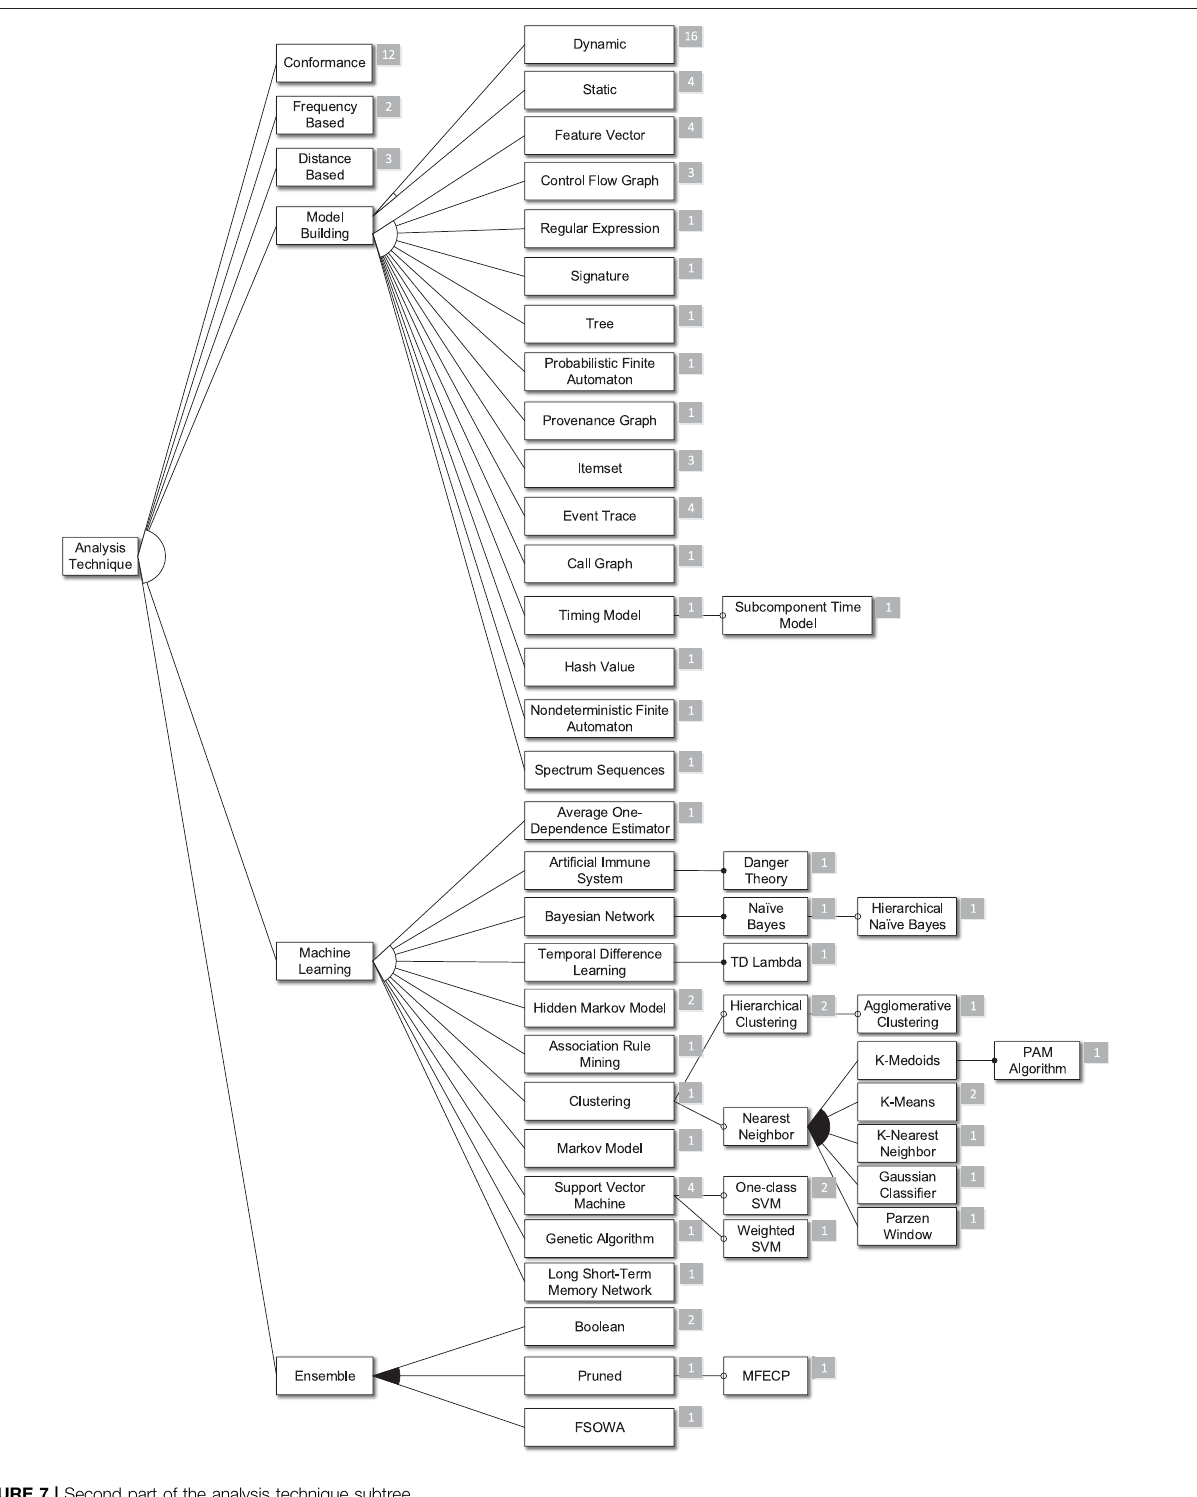
FIGURE 7 | Second part of the analysis technique